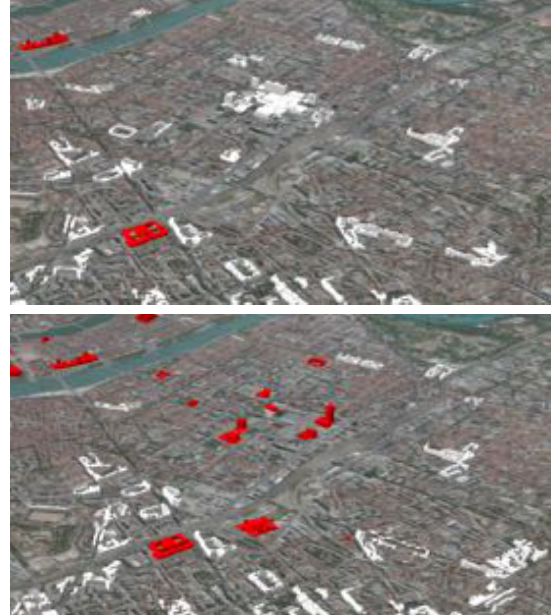
Figure 11: Different weight functions and 500,000 triangles limit. The top image uses W 1 and the bottom one W 2 . Red buildings are